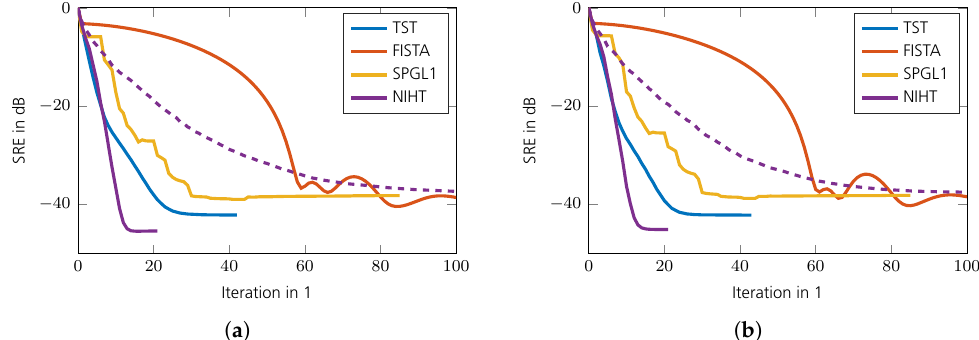
Figure 3. Comparison of convergence speed for κ / m = 0.25 and m / n = 0.5. The solid line shows NIHT for K = κ and the dashed line K = 2 κ . ( a ) Random sensing operators A ∼ CN ( 0,1 ) . ( b ) DFT sensing operators with random rows.